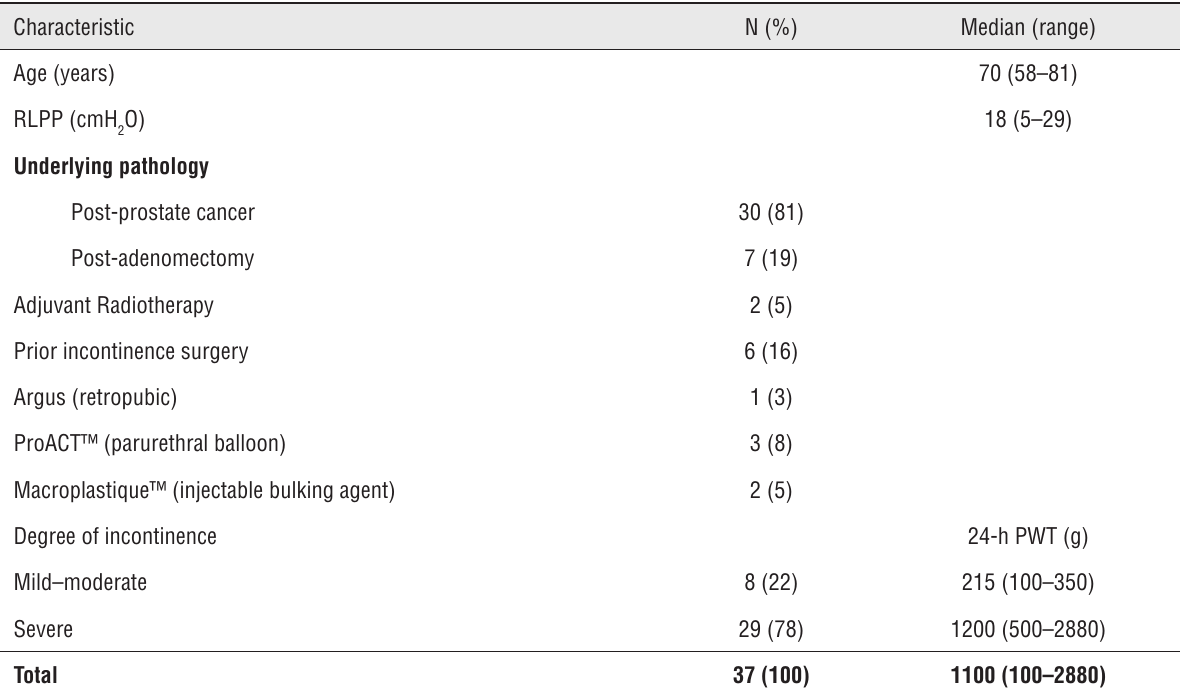
Table 1 - Patients’ baseline characteristics.